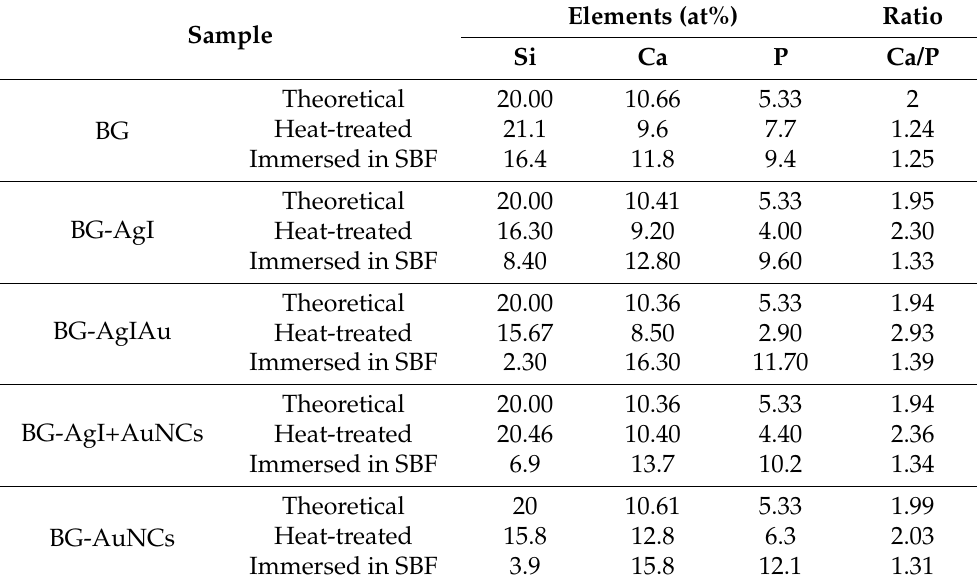
Table 3. Si, Ca, and P content of the heat-treated and immersed BG composites obtained from XPS measurements. For comparison, theoretical values were also calculated.